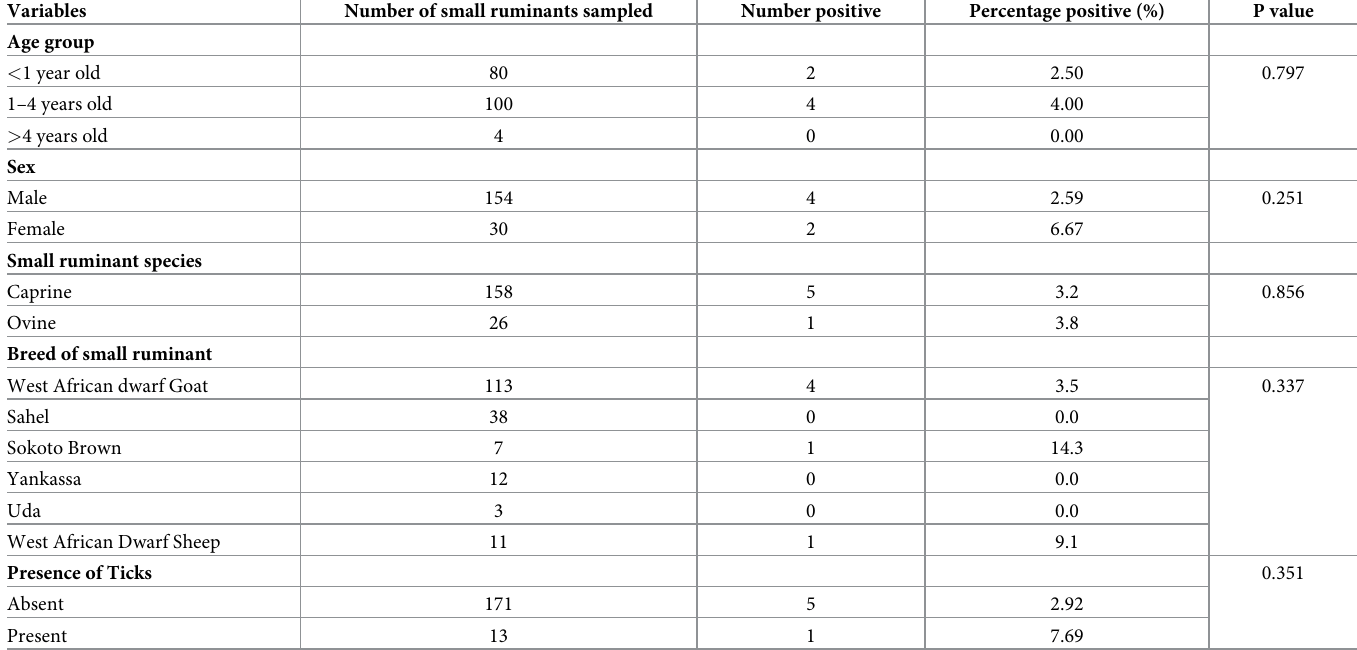
Table 3. Bivariate analysis of possible risk factors with seroprevalence of Coxiella burnetii in small ruminants slaughtered at Ipata Municipal Abattoir, Kwara State, northern